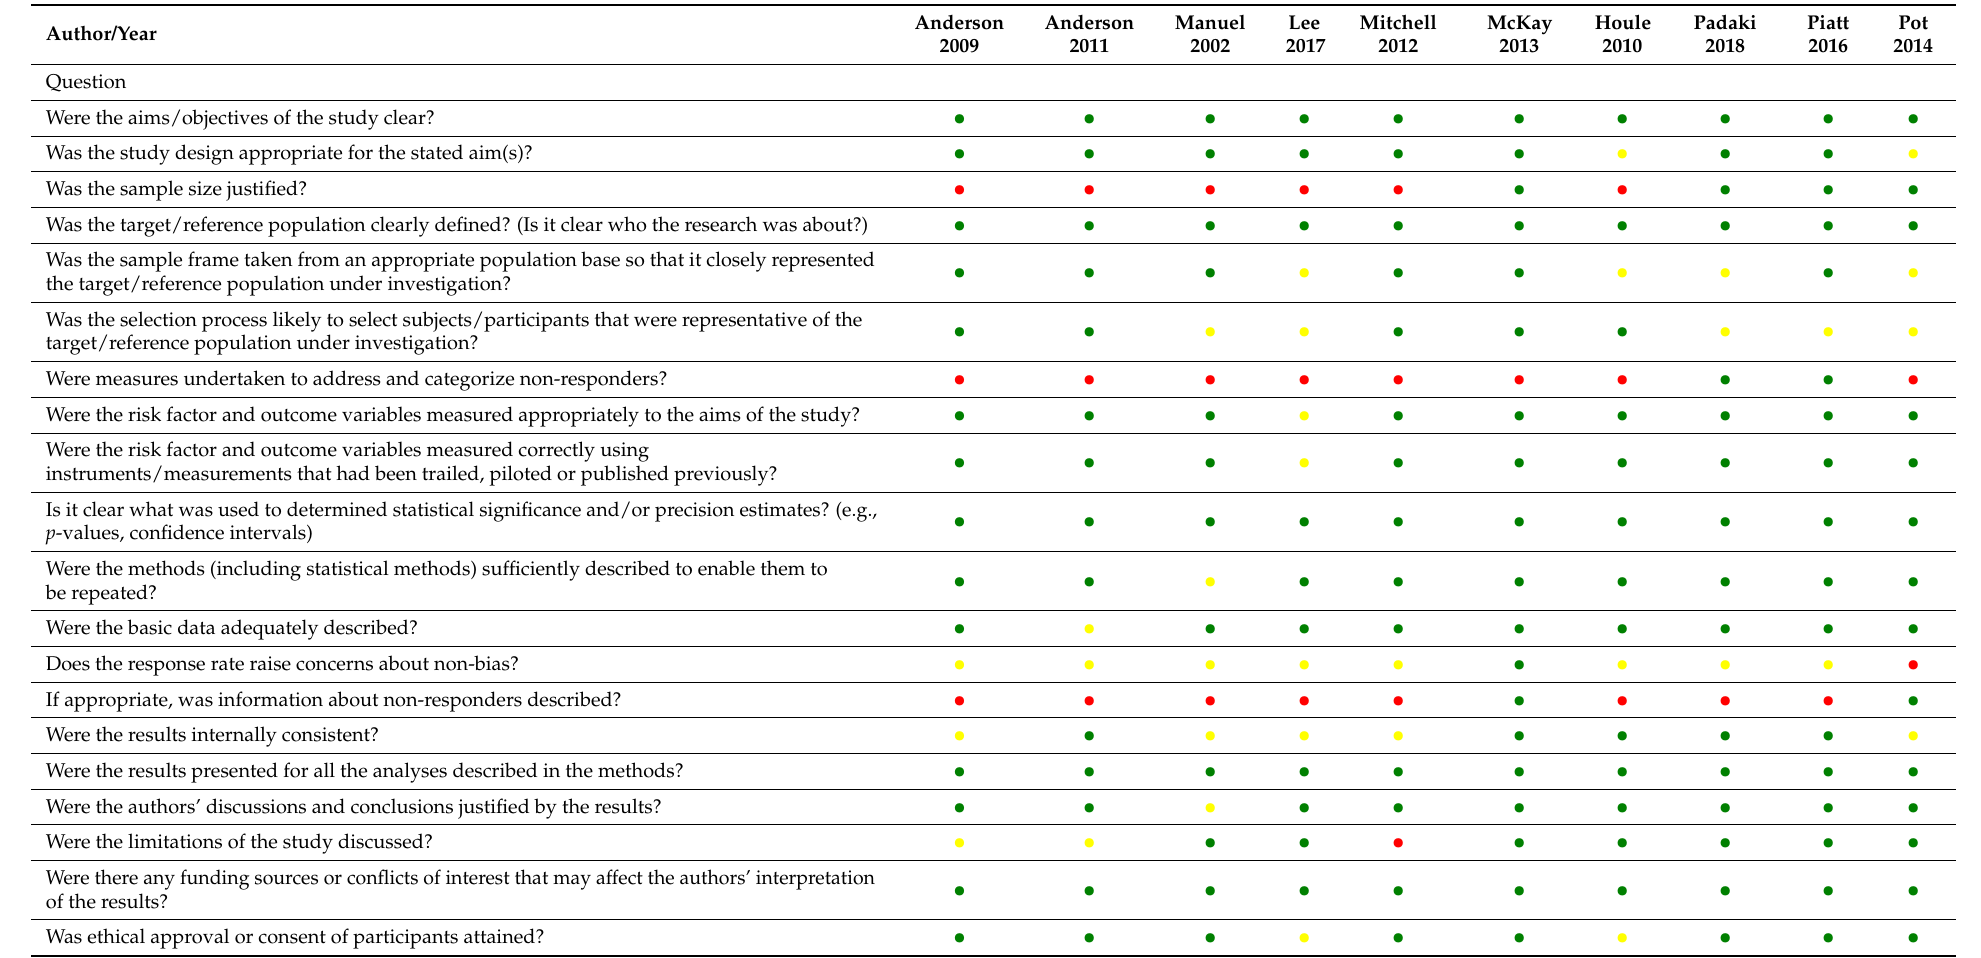
Table 2. AXIS Appraisal of